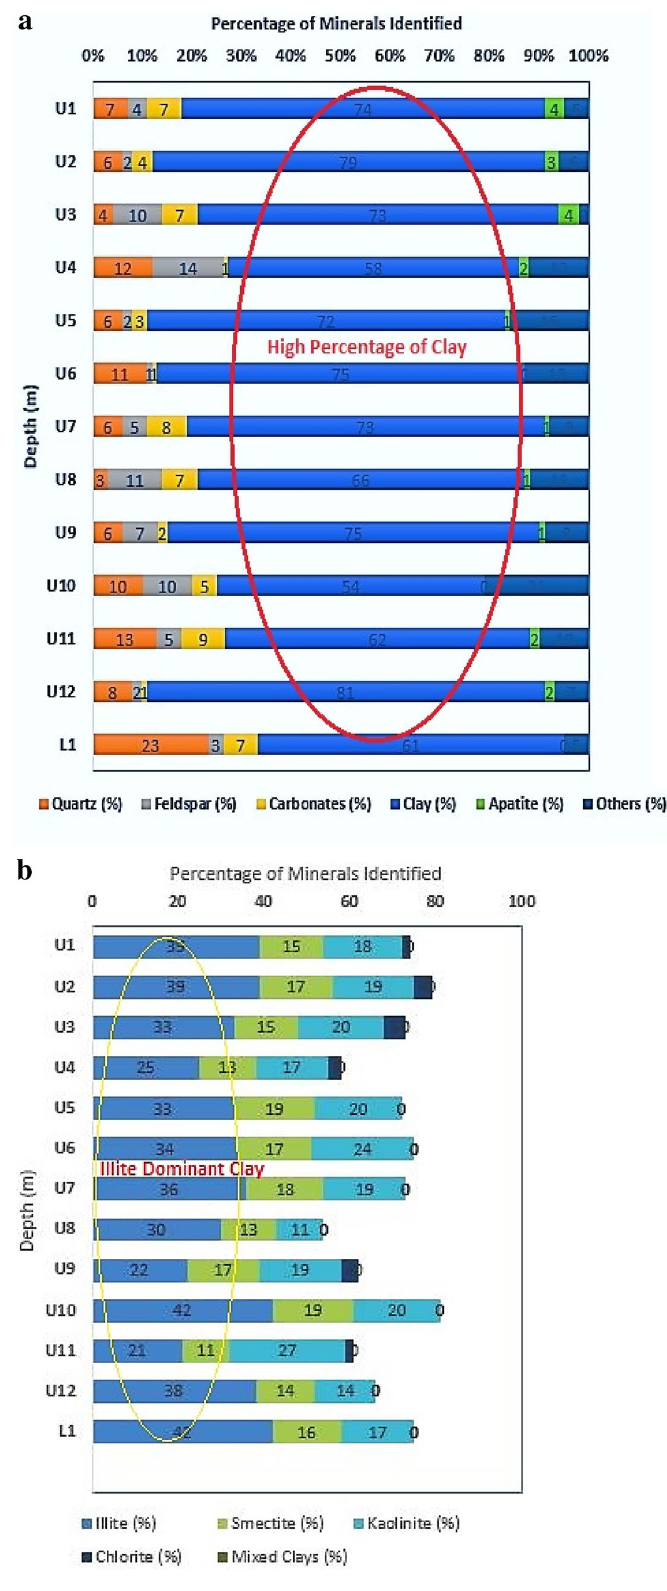
Fig. 3 a Illustrates the percent- age of Minerals identified in the samples U1 to U12 and L1. The percentage of Clay Minerals is high as compared to other minerals. b Gives the distribu- tion of clay minerals, i.e., Illite, Smectite, kaolinite, Chlorite and Mixed Clays with respect to depth intervals (U1–U12 and L1). This shows Illite is the dominant clay mineral as com- pared to other minerals present in the